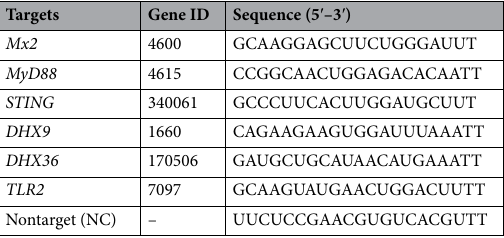
Table 4. siRNAs used in this